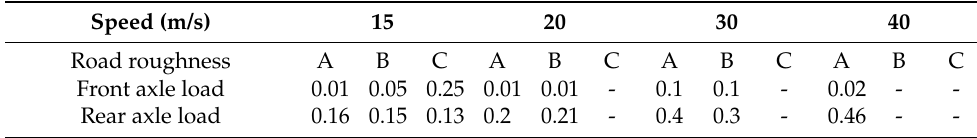
Table 7. The relative error (%) of the identified forces at noise 0%. Speed (m/s)